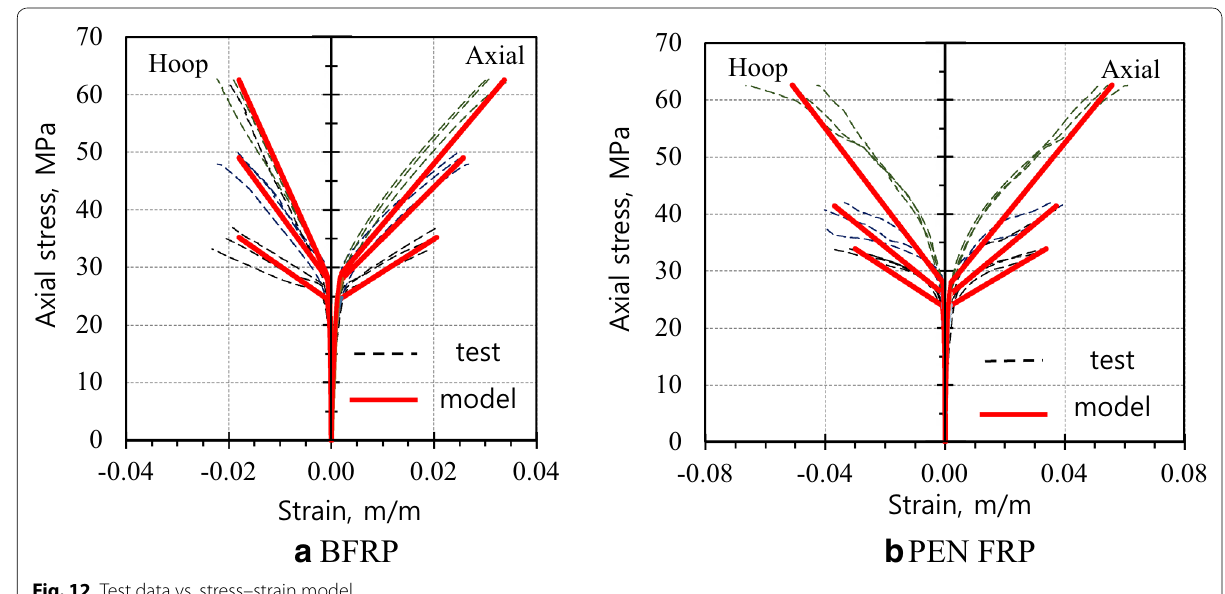
Fig. 12 Test data vs. stress–strain model.